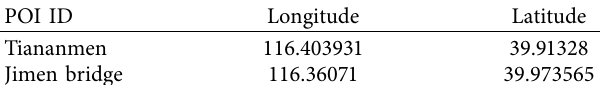
Table 3: Example of point-of-interest data. POI